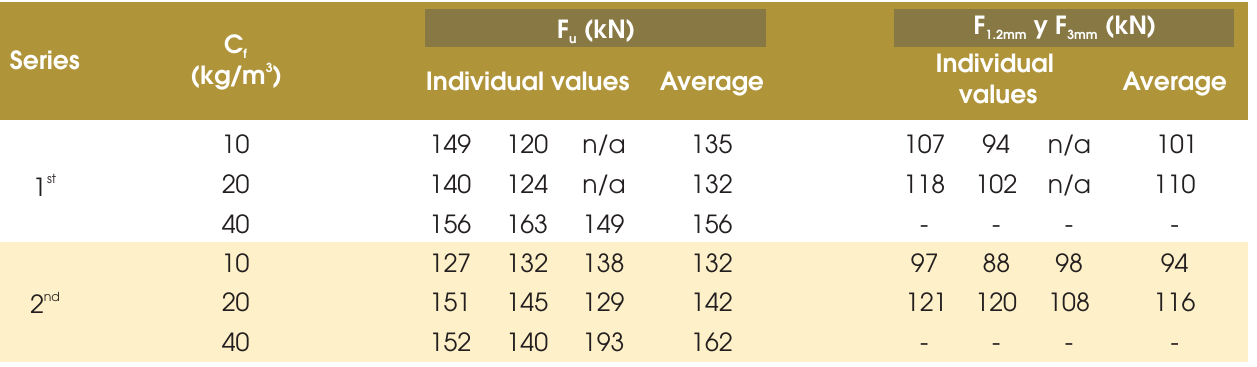
Table 3 – Maximum load and maximum post-peak load obtained in the two series of tests